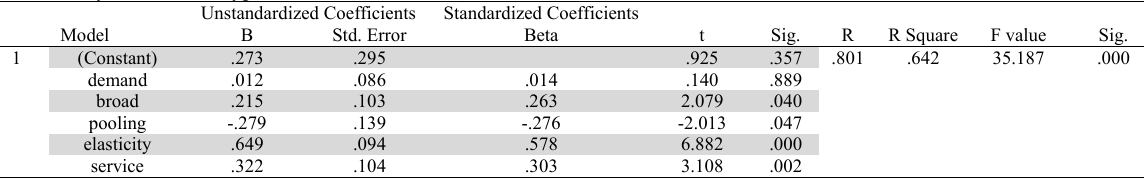
The summary of the main